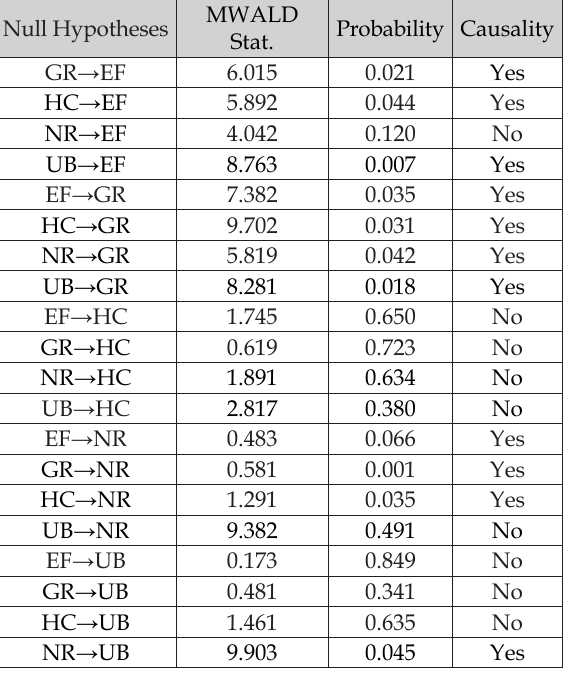
Table 10. Toda-Yamamoto test results.